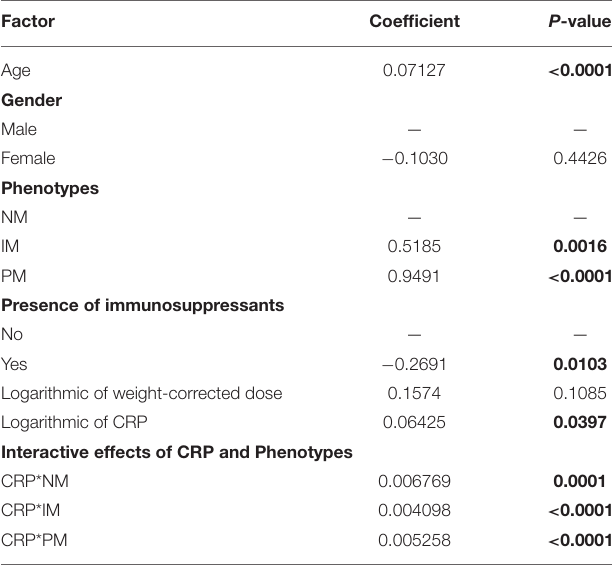
TABLE 3.1 | Multivariate linear mixed-effects regression analysis of the influence of covariates on voriconazole CDR ( µ g/ml per mg/kg).